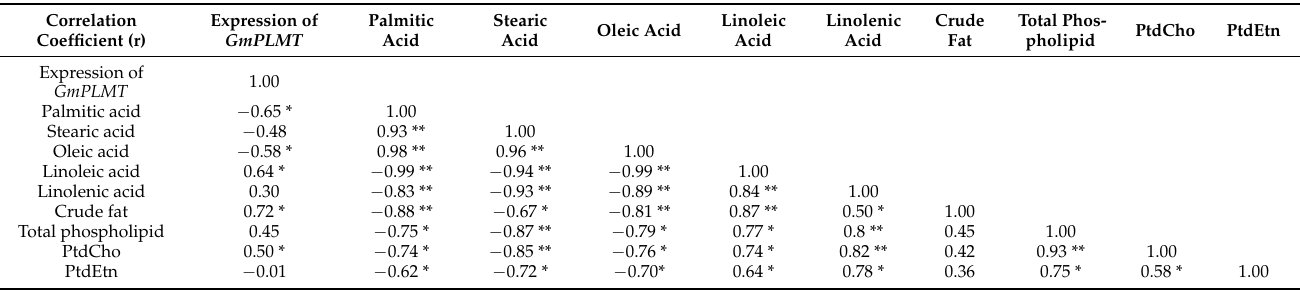
Table 2. Correlation analysis of GmPLMT gene expression and contents of various types of lipid metabolites in soybean grains at different stages of